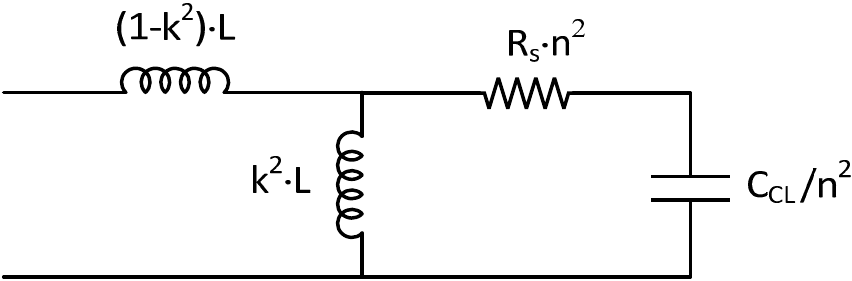
Figure 8. Simplified electric equivalent circuit of wireless temperature sensor.